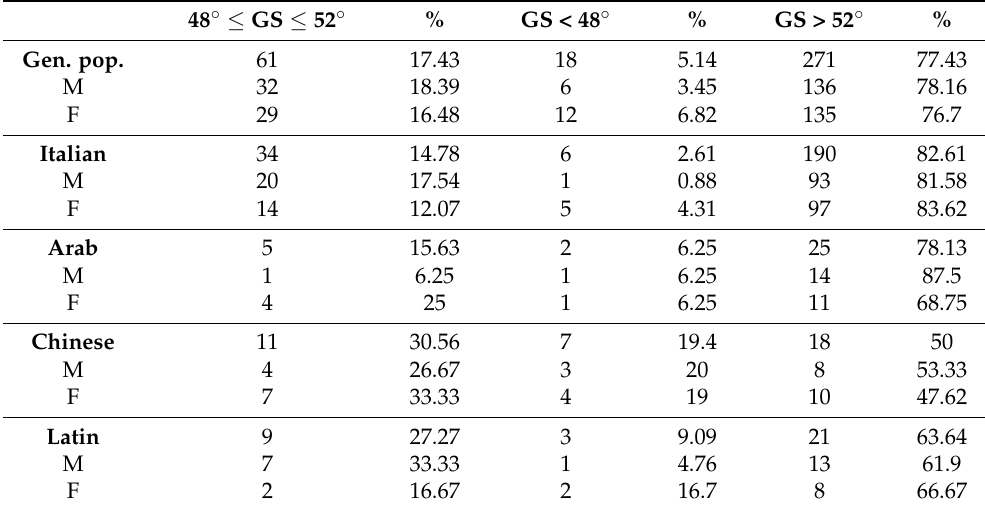
Table 12. Distribution of the upper gonial angle values in the selected patient